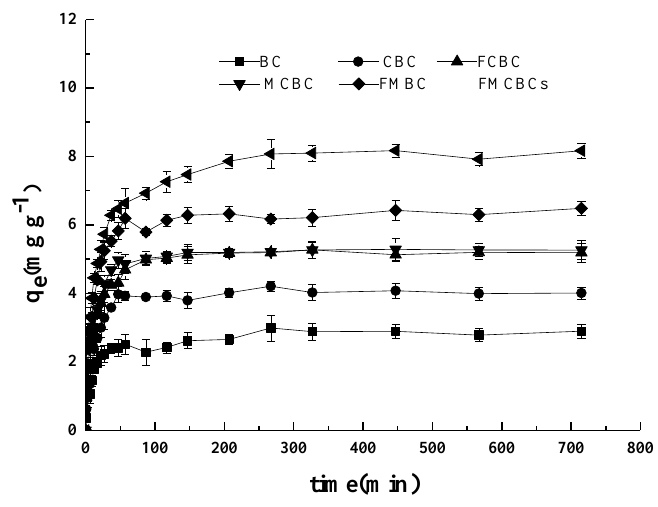
Figure 6. The adsorption kinetics of As(III).